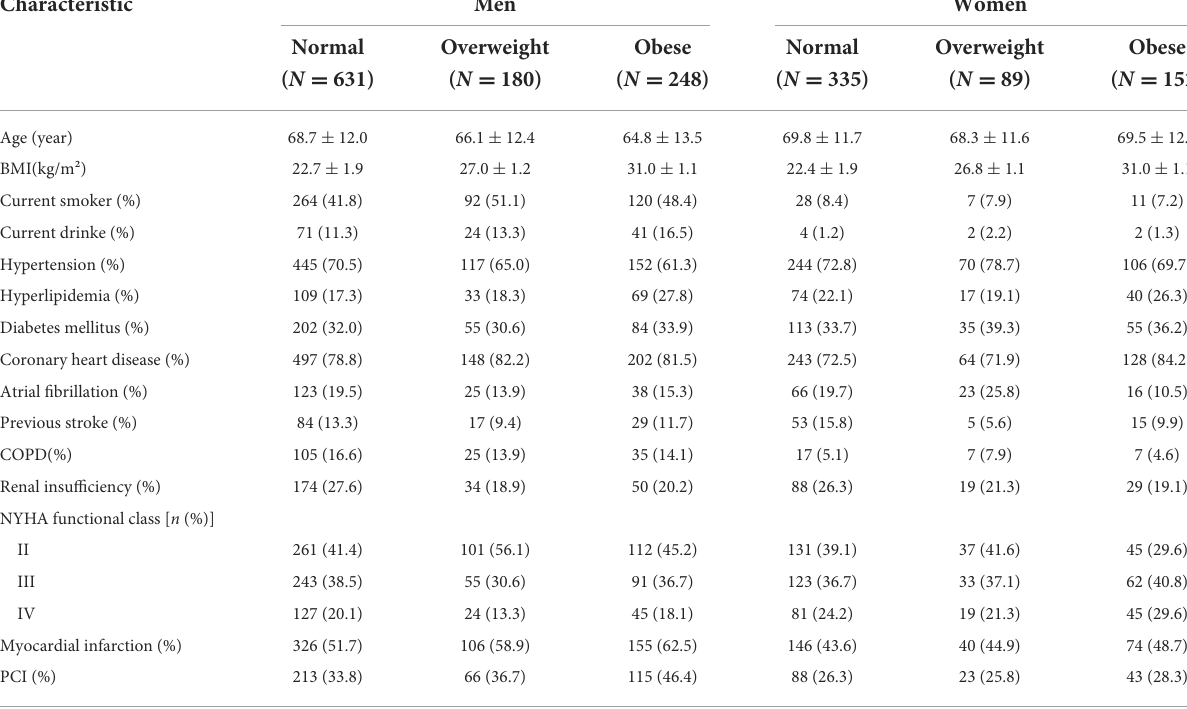
TABLE 1 Base-line characteristics according to the category of body-mass